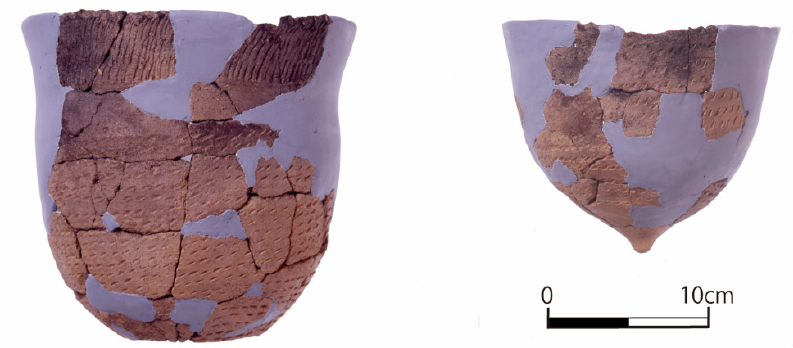
Figure 7. PotteriesfromtheTaisho-3site. Thesearetheso-callednail-impressedwares. Reproducedfrom[90], Figure 7. Potteries from the Taisho-3 site. These are the so-called nail-impressed wares. Reproduced with the permission of the Obihiro Centennial City from [90], with the permission of the Obihiro Centennial City Museum.